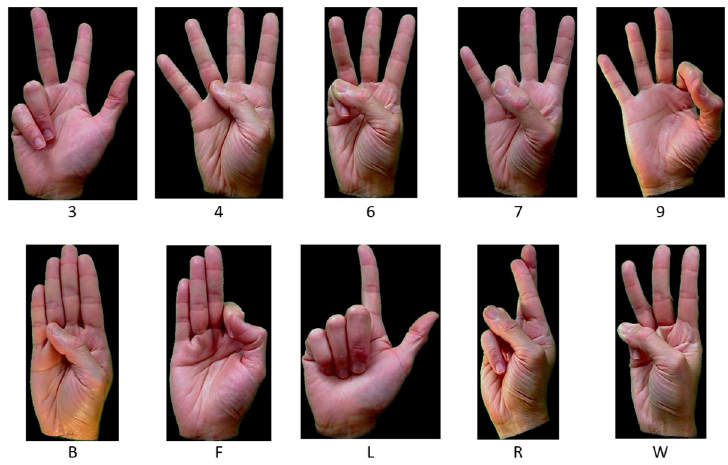
Figure 7. A subset of the American sign language dataset.